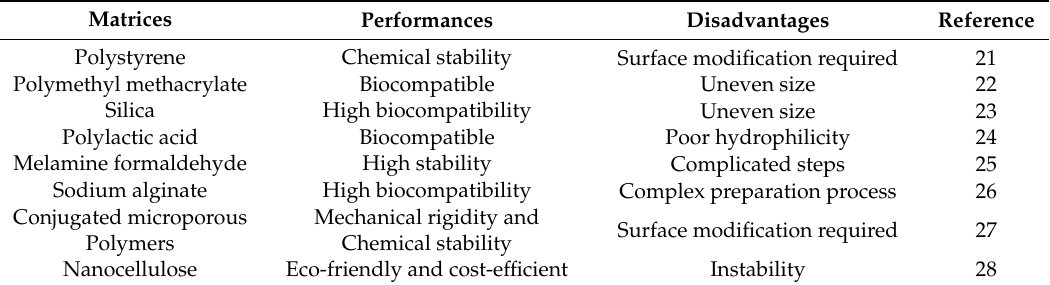
Table 1. The pros and cons of di ff erent matrix